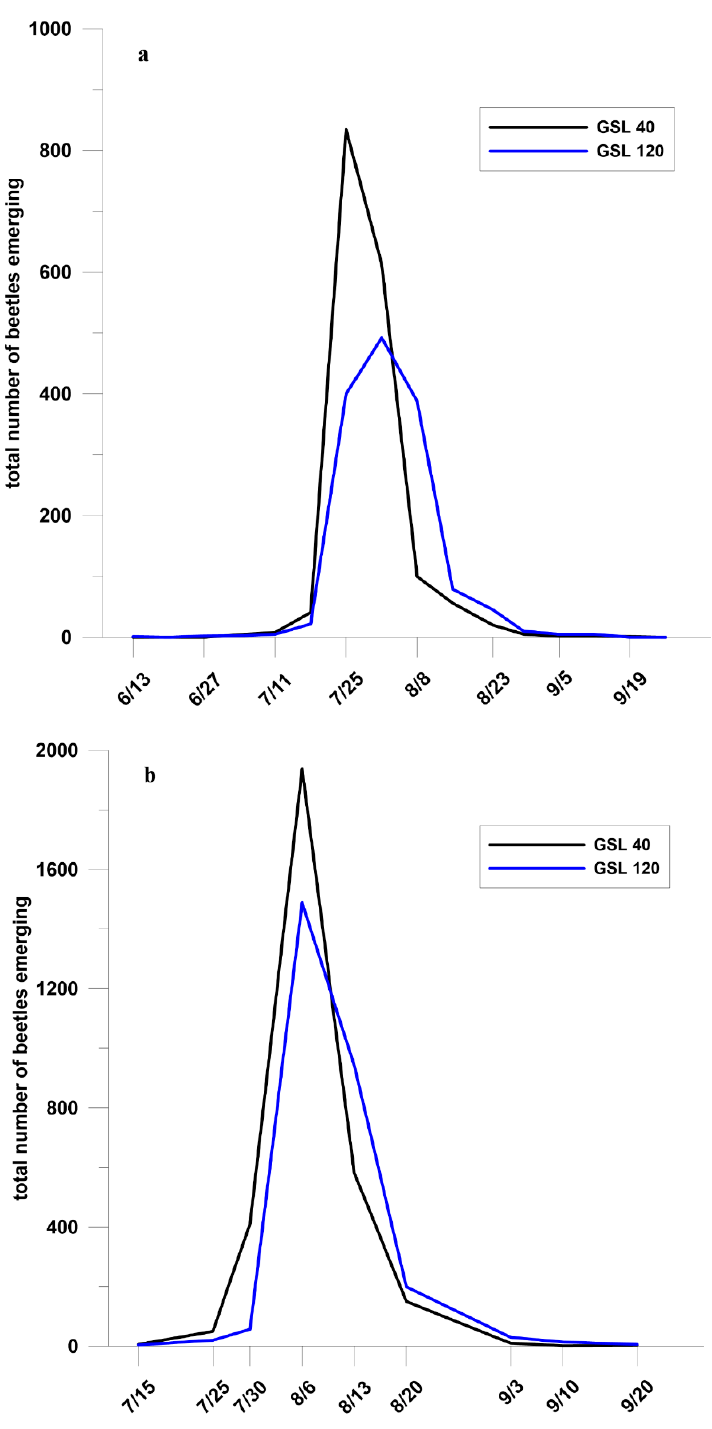
Figure 2. Emergence of Dendroctonus ponderosae from Pinus contorta at growing stock levels 40 and 120, n = 20 for each GSL, ( a ) Fraser Experimental Forest, CO, 2007; and ( b ) Colorado State Forest, CO,